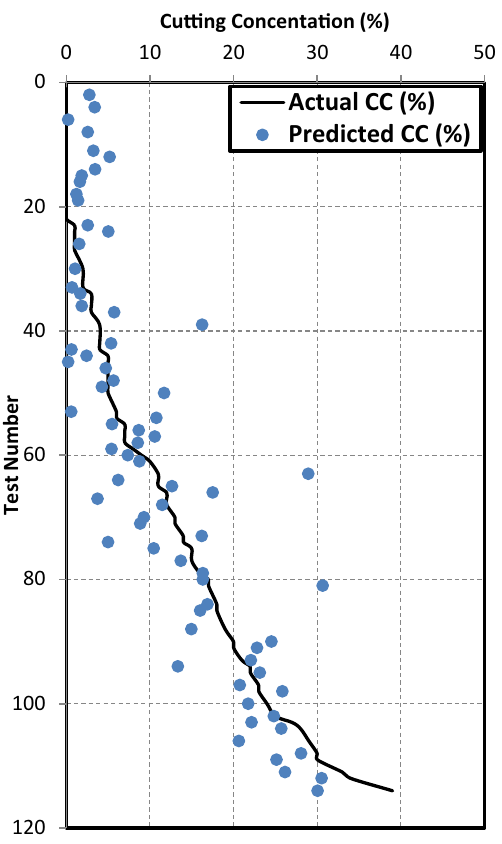
Fig. 5 Actual (experimental) and BPNN-predicted cutting concentra- tion versus test number from network